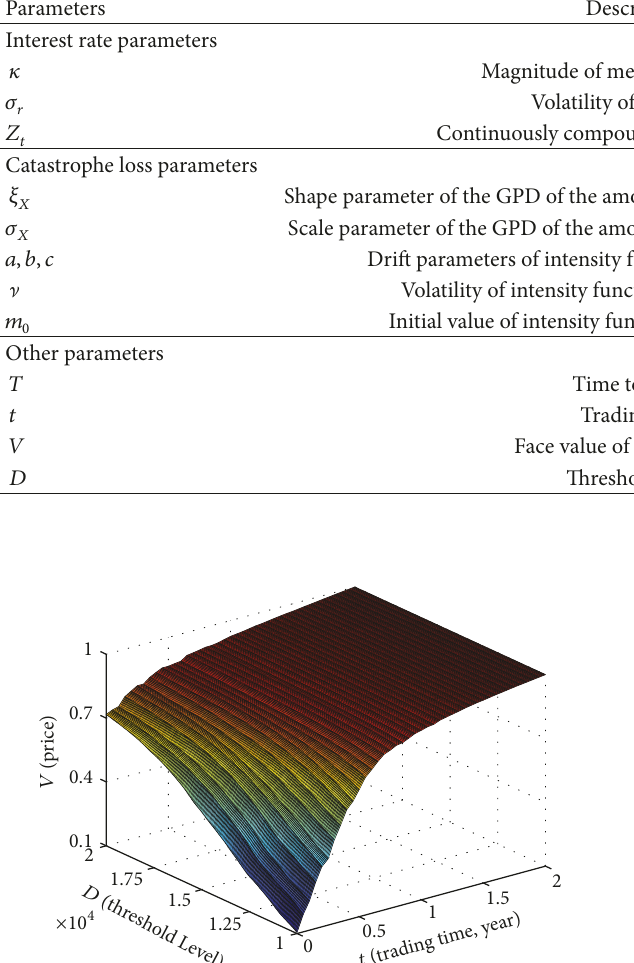
Figure 13: The difference between the zero-coupon CAT bond price Figure 12: The zero-coupon CAT bond price with respect to the in stochastic interest rates and the deterministic interest rate under threshold level and trading time. The model parameters are 𝜉 𝑋 = the lognormal and the DSPP assumptions. The model parameters 0.9238, 𝜎 = 15.5797, 𝑚 = 22.3512, 𝑎 = 0.0457, 𝑏 = 𝑋 0 are 𝜉 𝑋 = 0.9238, 𝜎 𝑋 = 15.5797, 𝑚 0 = 22.3512, 𝑎 = 0.0457, 𝑏 = 0.7388, 𝑐 = −0.6423, ] = 0.5, 𝜅 = 0.1 , and 𝜎 = 0.01 . 0.7388, 𝑐 = −0.6423, ] = 0.5, 𝜅 = 0.1 , and 𝜎 𝑟